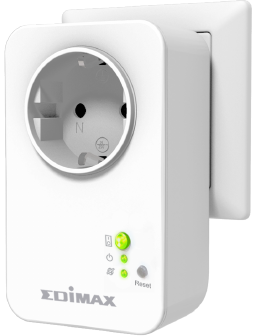
Figure 4. EDIMAX Smart Plug Switch